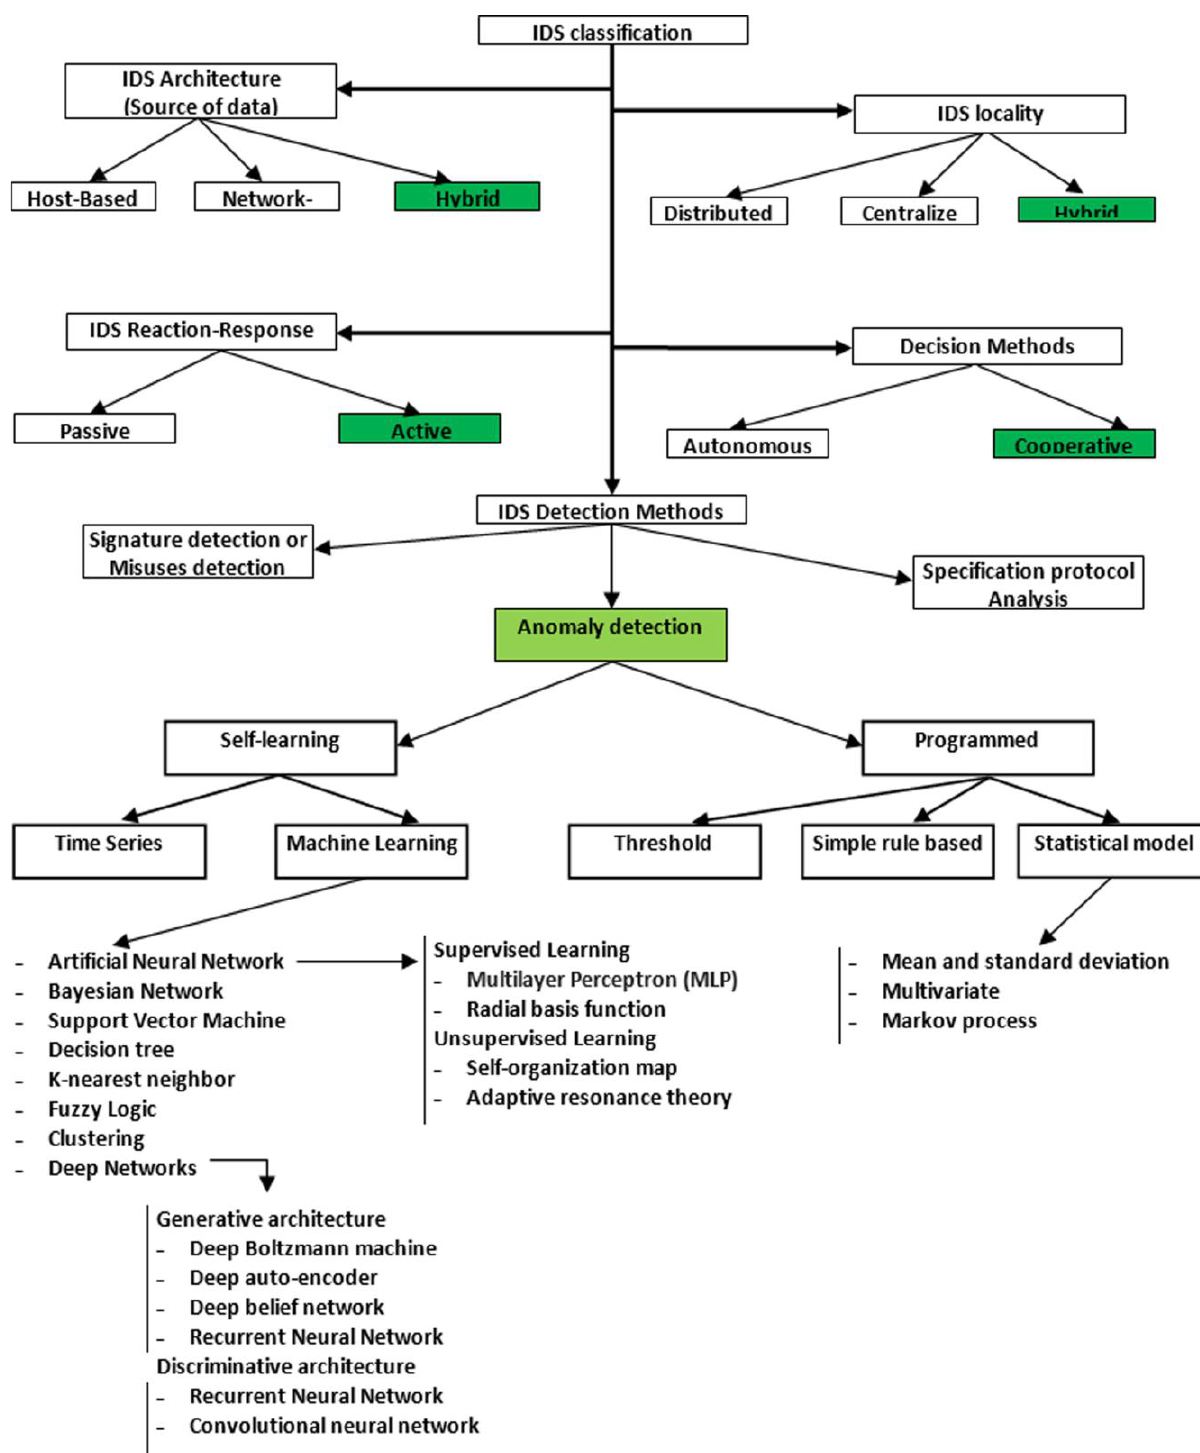
Figure 36. Modern intrusion detection system (IDS) classification based on five factors: architecture, locality, reaction–response, decision class, and detection methods [114]. Abbreviations used: IDS, intrusion detection system. Reprinted with permission from ref. [114]. 2020 Elsevier.